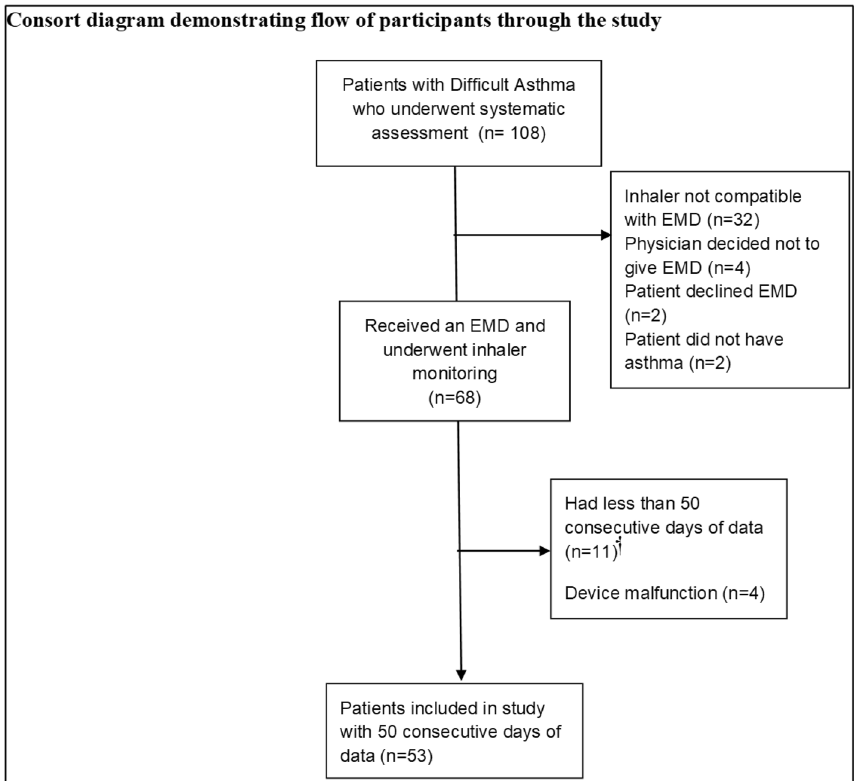
Figure 4. Consort diagram demonstrating flow of participants through the study. EMD electronic monitoring device. † Due to EMD detachment. (Microsoft Powerpoint, version 2101, https:// office. live. com/ start/ power point.